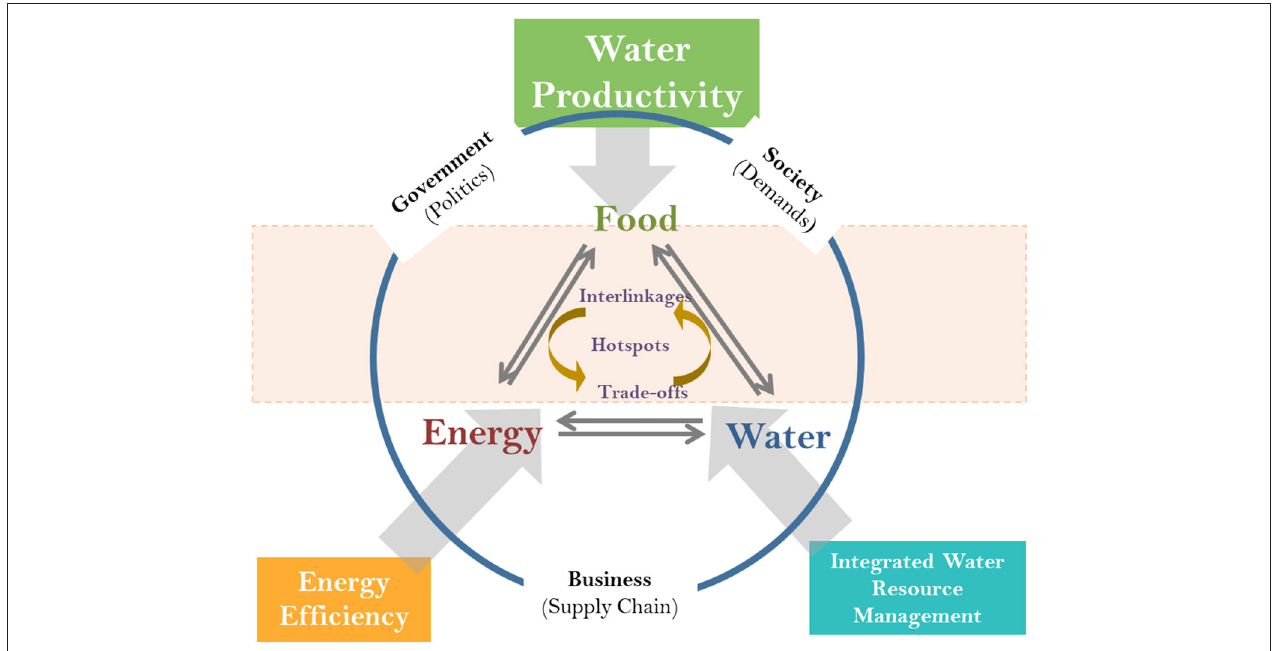
FIGURE 2 | Connectivity of the nexus elements (Mohtar and Daher,